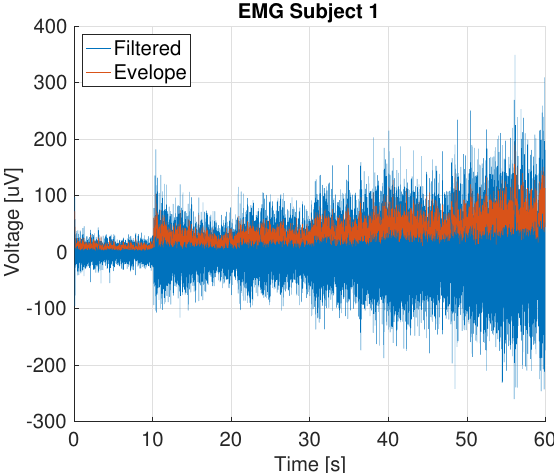
Figure 11. EMG recording and its envelope from the load test of subject 1 (D16_IED20 electrode); the load was increased from 0kg to 5kg in ten second